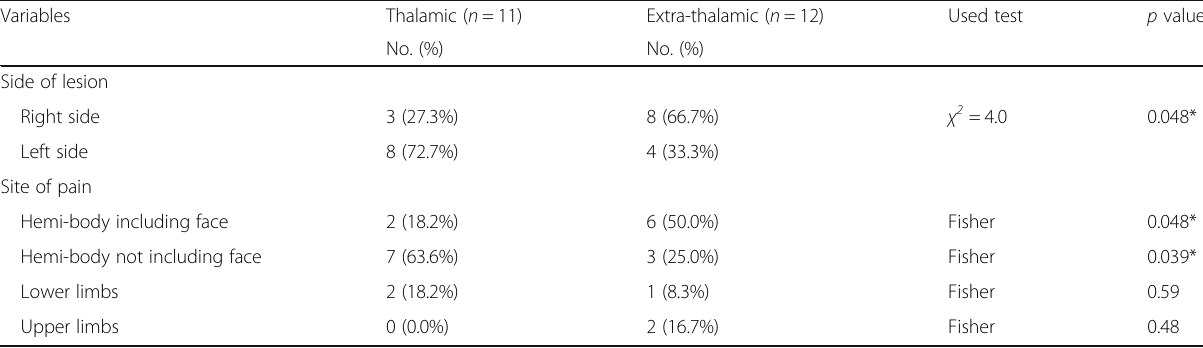
Table 2 (MRI) findings according to side of lesion and site of pain Variables Thalamic ( n = 11)